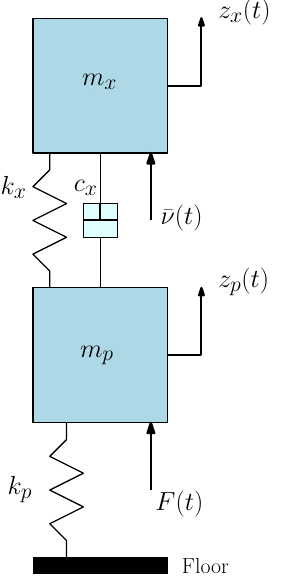
Figure 1. The dynamical system considered for numerical